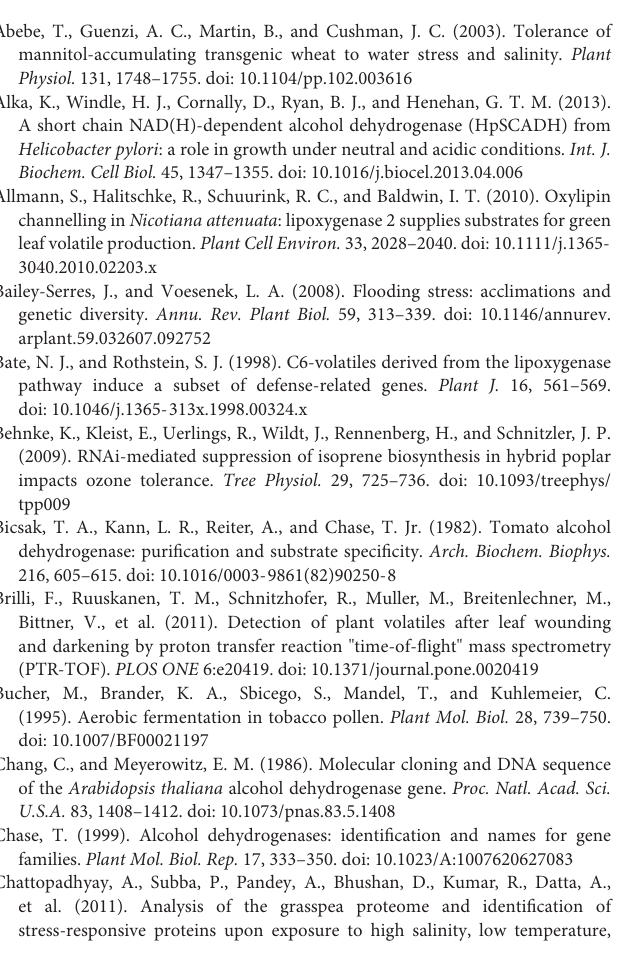
by Synechocystis sp. proteins are presented in gray, while amino acids conserved among all three ADHs are in black. The major functional domains are indicated, along with the binding sites of the catalytic ( ∗ ) and structural ( • ) Zn ions. The β sheets of the NAD-binding Rossmann fold are underlined. GenBank accessions for PCC 6906, PCC 6803, and horse liver ADHs are KY014075, WP_010874320, and NP_001075414.1, respectively. FIGURE S2 | Analysis of sysr1 -overexpressing transgenic N. benthamiana lines. (A) transformation of N. benthamiana plants. (B) Quantitative real-time PCR analyses of sysr1 gene expression in WT plants and sysr1 -overexpressing transgenic lines (T 1 ). Total RNA was isolated from untreated plants and cDNA was synthesized as described in the “Materials and Methods” section. The EF1 α gene was used as a reference gene. (C) Images of representative sysr1 transformants and WT plants at 50 days. FIGURE S3 | Effects of osmotic stress (400 mM mannitol) on shoot and root growth in the control and three transgenic plants (Lines 1, 4, and 7). (A) Plants were photographed after 4 weeks of stress treatment. Two-week-old WT and transgenic plants (Lines 1, 4, and 7), grown on Murashige and Skoog agar medium, were transferred to the same medium supplemented with 400 mM mannitol, and plants were allowed to grow for an additional 4 weeks. (B) Primary root lengths of WT and transgenic plants treated with 400 mM mannitol for 4 weeks ( n = 12). The data for three biological replicates were averaged. Different letters represent significant differences at P < 0.05 ( t -test). Bars indicate the standard deviation of the